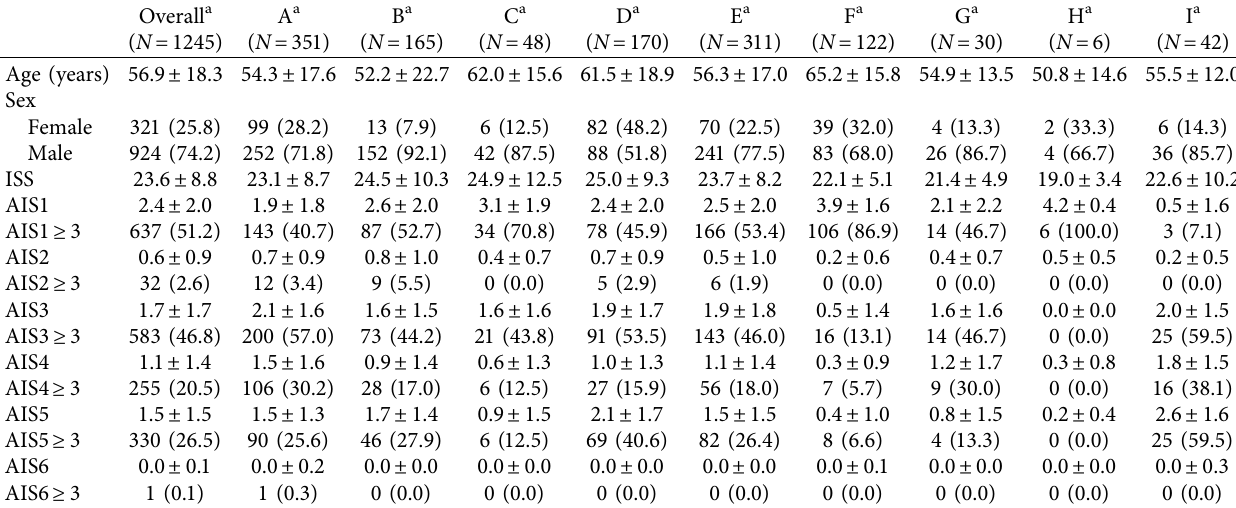
Table 1: Patients’ clinical characteristics analyzed by mechanisms.